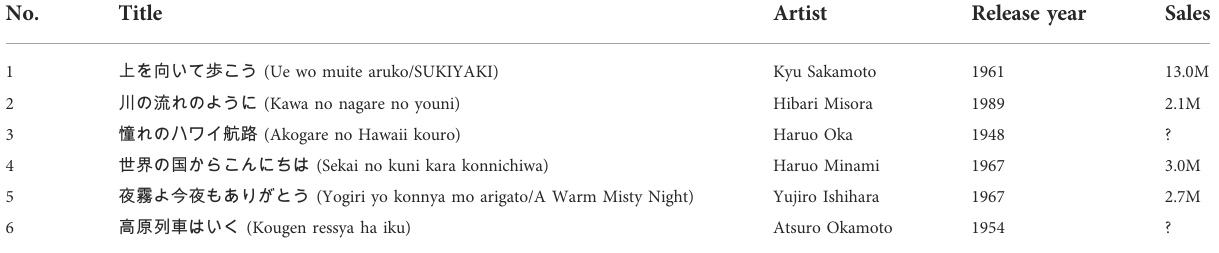
TABLE 1 Selected songs for music listening experiment.